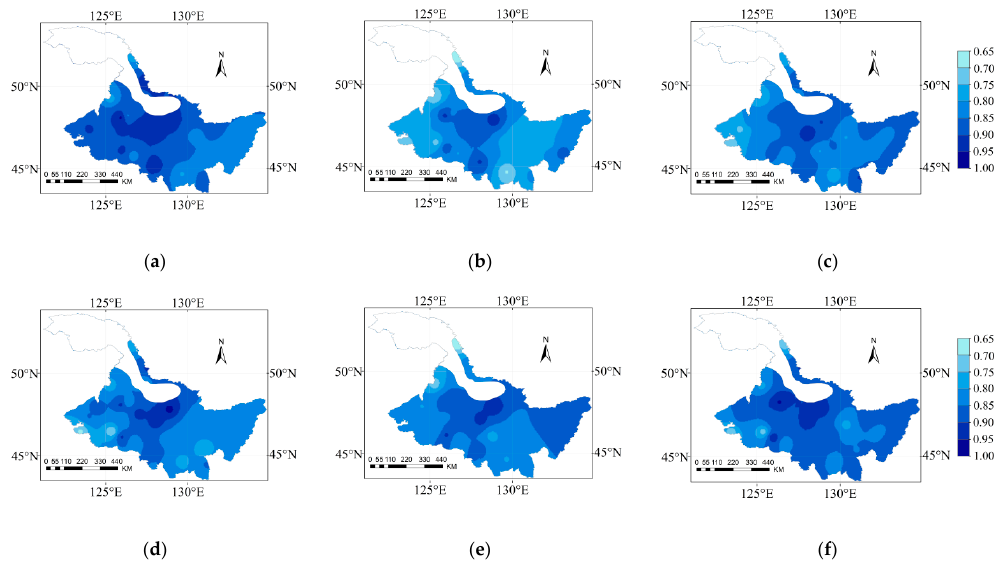
Figure 10. Spatial distribution of CD during the ( a ) 2030s, ( b ) 2050s, and ( c ) 2070s under RCP4.5, and during the ( d ) 2030s, ( e ) 2050s, and ( f ) 2070s under RCP8.5 during the soybean growth period. The climate tendency rate of CD during the soybean growth period from 2021–2080 under the RCP4.5 was − 0.036–0.014/(10 years), with an average value of − 0.007/(10 years),